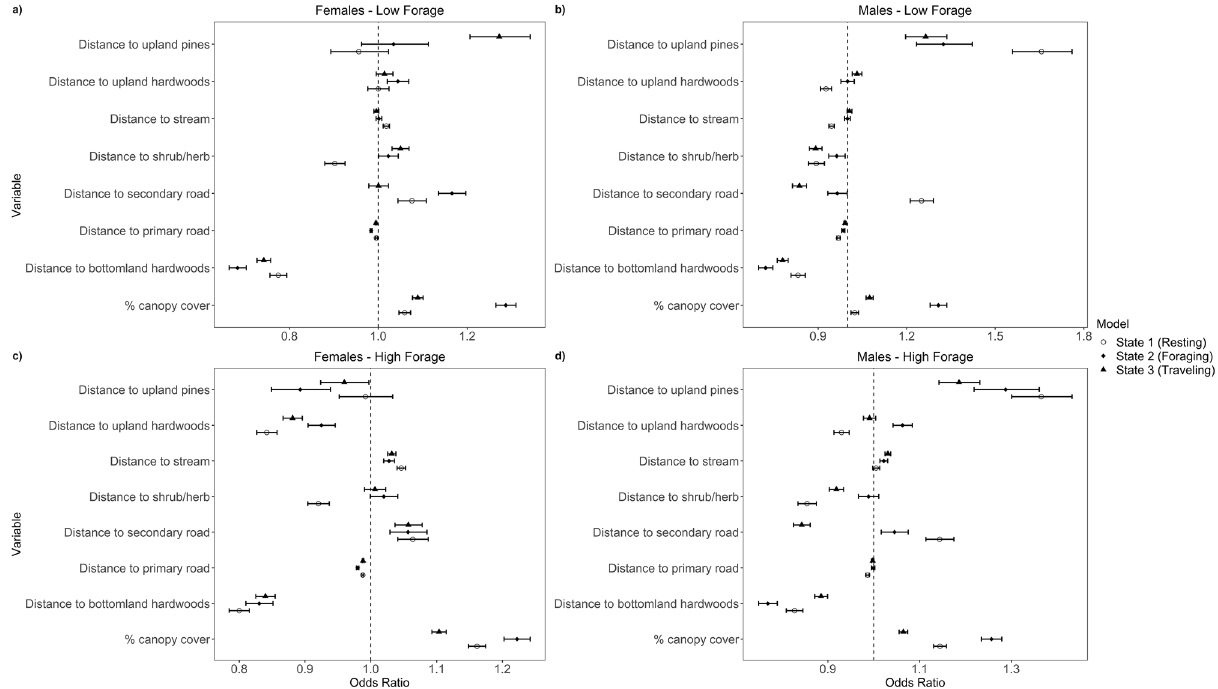
Figure 6. Predictive odds with 95% confidence intervals of third-order selection of male and female wild pigs ( Sus scrofa ) on the Savannah River Site in South Carolina during two distinct seasons based on forage availability [i.e., low-forage season (January–April) and the high-forage season (May–December)]. It demonstrates selection or avoidance of vegetation types, streams, and characteristics of development (e.g., roads) for every 100 m increase and canopy cover for every 10% increase by state where states represent resting, foraging, and traveling behaviors, respectively: ( a ) Females in low-forage months (January–April); ( b ) males in low-forage months; ( c ) females in high-forage months (May–December); ( d ) males in high-forage months. In cases where the confidence interval crosses 1, the variable is considered not